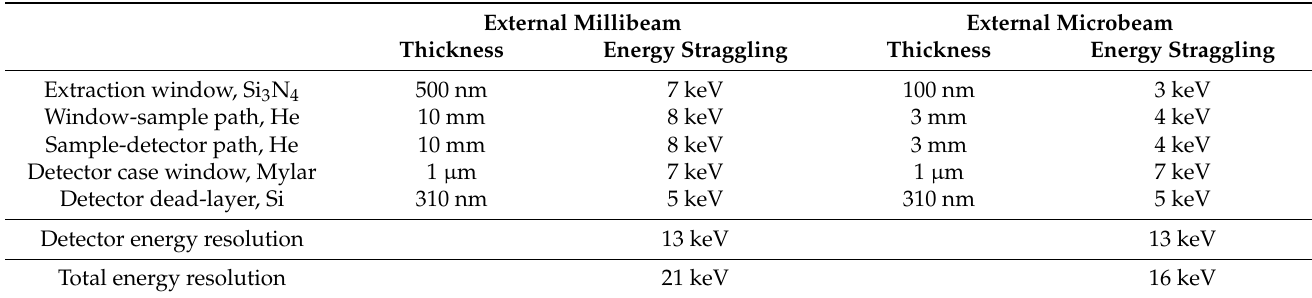
Table 2. Total energy resolution FWHM, achievable in external beam RBS with 3 MeV protons, according to two different ideal set-ups, namely, using extracted standard or millimetre-sized beams